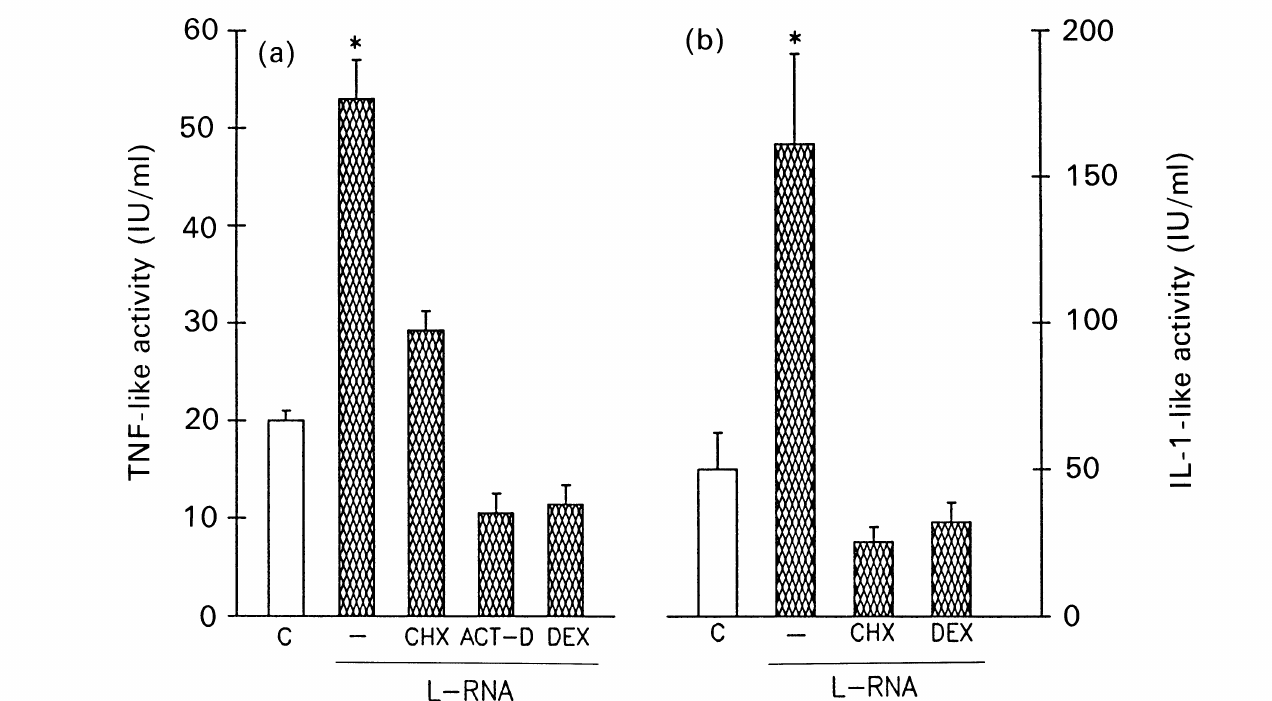
Fig. 4. The effect of pretreatment of resident macrophages with cycloheximide, actinomycin-D and dexamethasone on the release of TNF- and IL-1 induced by L-RNA. Cycloheximide (CHX; 10#g/ml), actinomycin-D (ACT-D; 10#g/ml) or dexamethasone (DEX’ 3#g/ml) were added to RPMI medium 30 min before the addition of L-RNA (25 #g/ml). Incubation time was 6 h. The TNF- activity (panel A) and the IL-1 activity (panel B) were quantified as described in Materials and Methods. Results are the